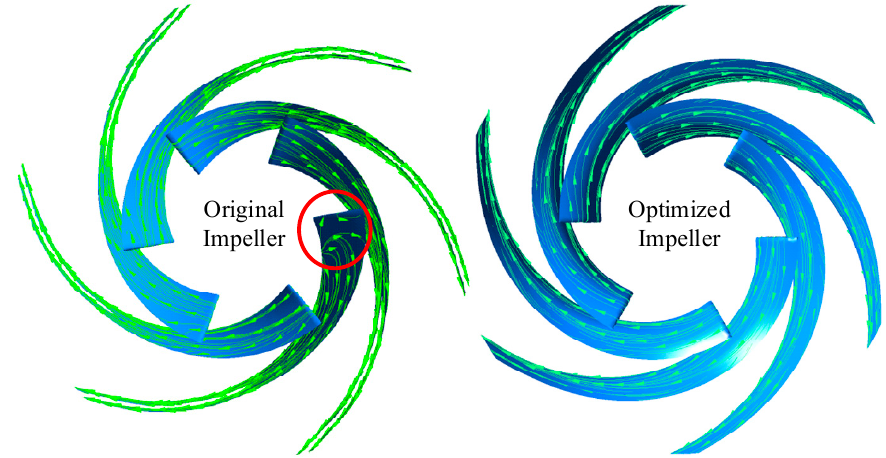
Figure 19. Comparison of streamline on blade surface at no cavitation condition.